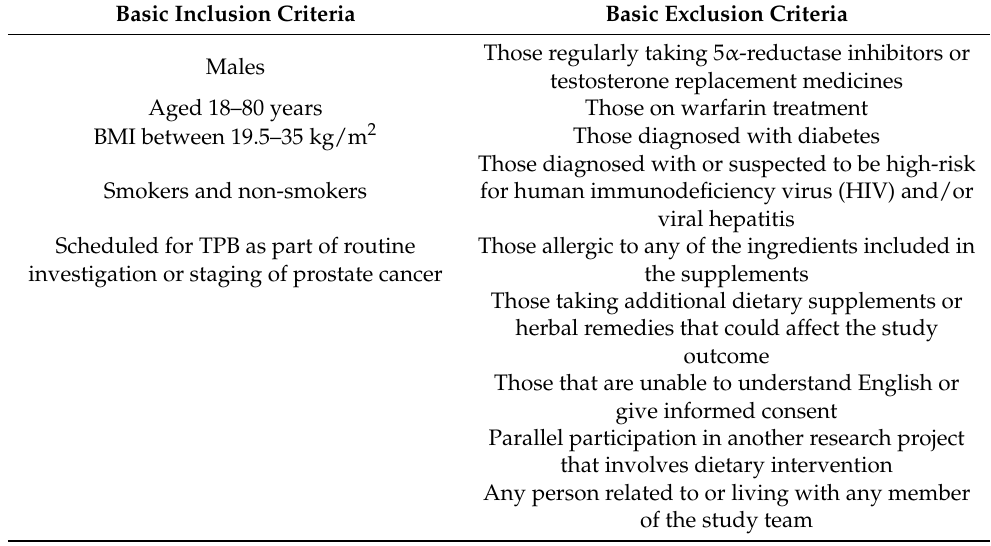
Table 1. Inclusion and exclusion